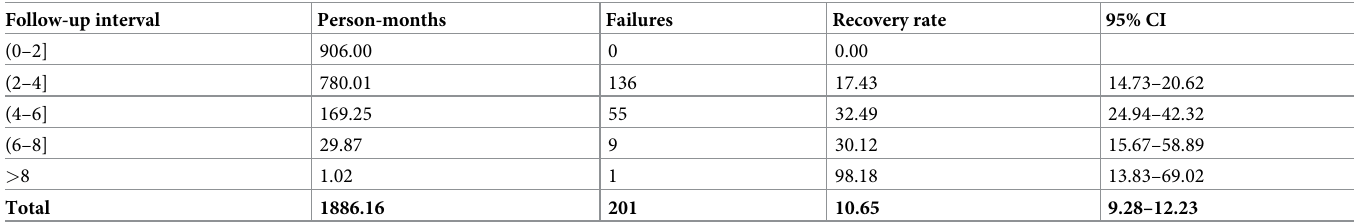
Table 4. Recovery rate at particular time interval of HIV/ADIS adult patients treated with RUTF at Debre Markos Referral Hospital from July of 1 st , 2015 to December of 31 st , 2017. Follow-up interval